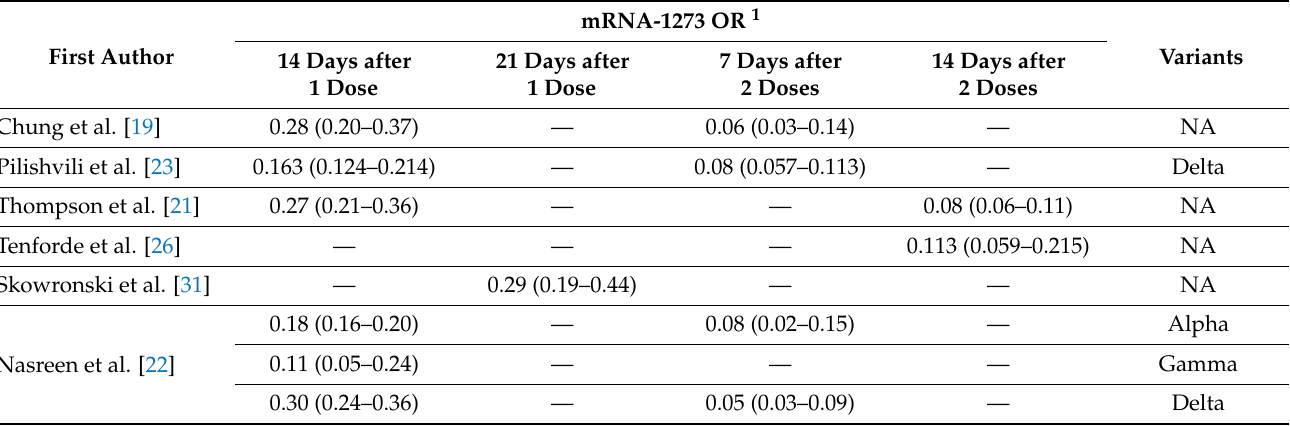
Table 3. Effectiveness of the mRNA-1273 vaccine against SARS-CoV-2 infection after 1 dose and